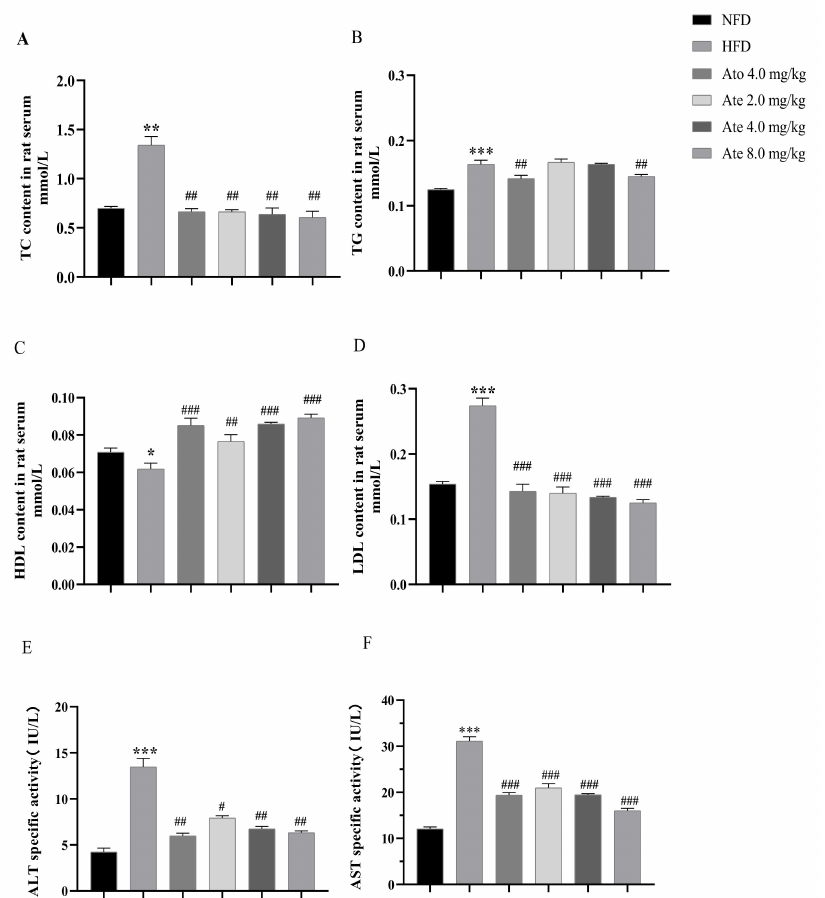
Figure 4. The effects of Ate on rat serum biochemistry. The levels of ( A ) TC, ( B ) TG, ( C ) HDL, ( D ) LDL, ( E ) ALT, and ( F ) AST in serum of rats are shown. All data are presented as mean ± SEM, n = 6–15. * p < 0.05, ** p < 0.01, and *** p < 0.001 compared with the NFD group; # p < 0.05, ## p < 0.01, and ### p < 0.001 compared with the HFD